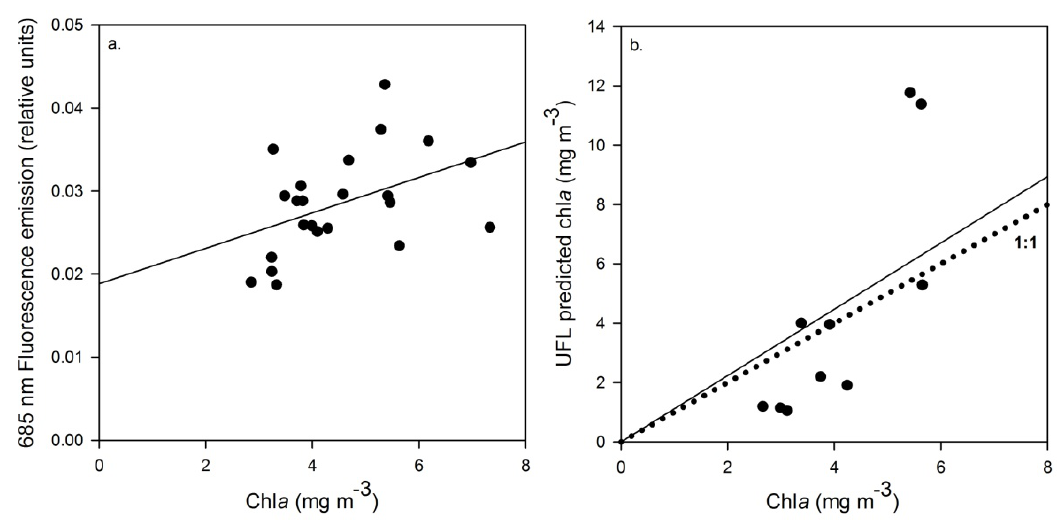
Figure 9. Field campaign specific ( a ) calibration (chl a = 0.002 × UFL R = 0.44; p < 0.05) and ( b ) validation of UFL chl a measurements (R = 0.83; p < 0.002; RMSE = 0.71 mg·m − 3 ). Solid line is regression trend line; dotted line is 1:1.